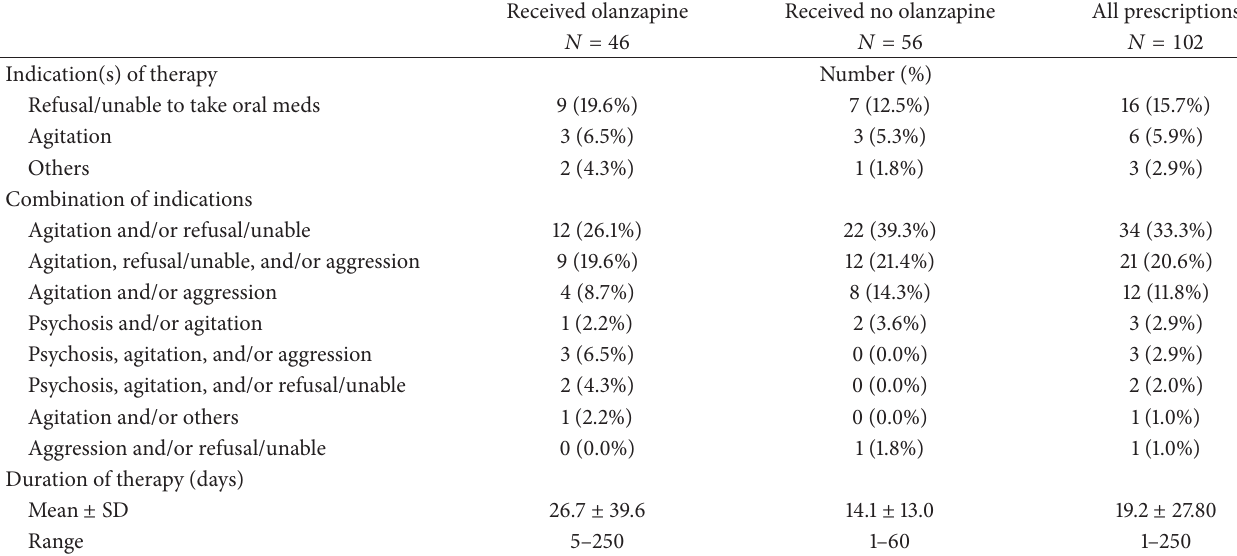
Table 2: Prescribing patterns of olanzapine IM.